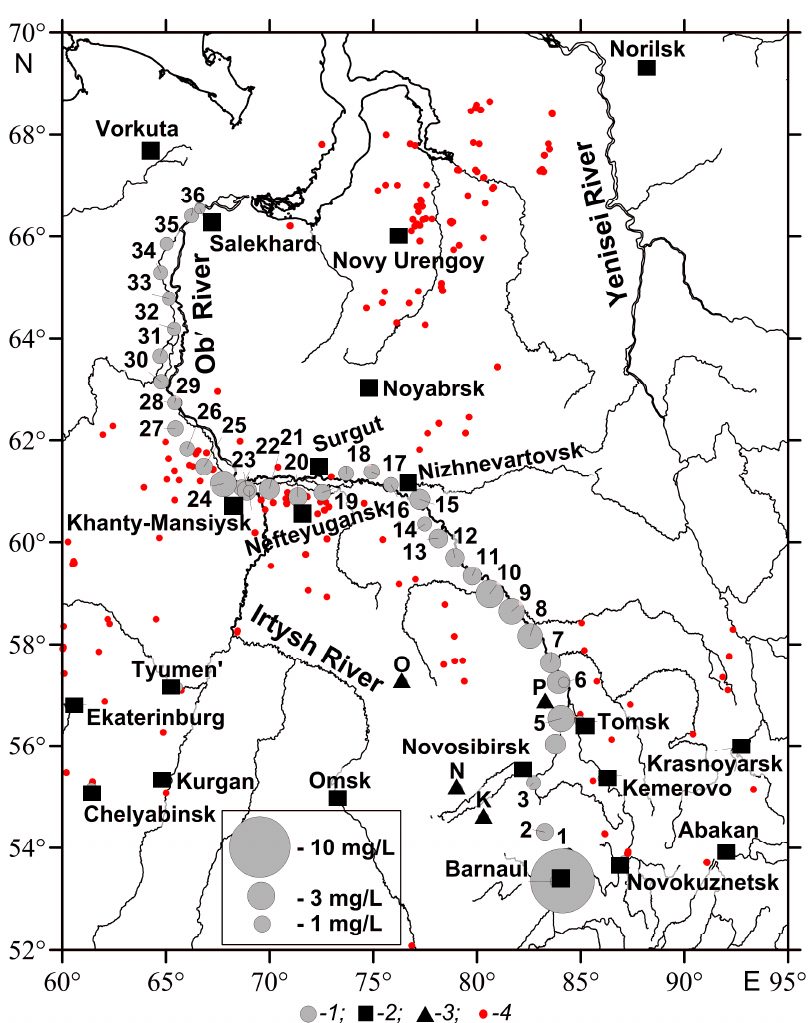
Figure 1. Studied area: 1—positions of the sampling sites (sizes of circles reflect the concentrations of particulate matter); 2—large cities; 3—sites of snowpack studies in [49]; 4—the positions of gas flaring taken from [51] .